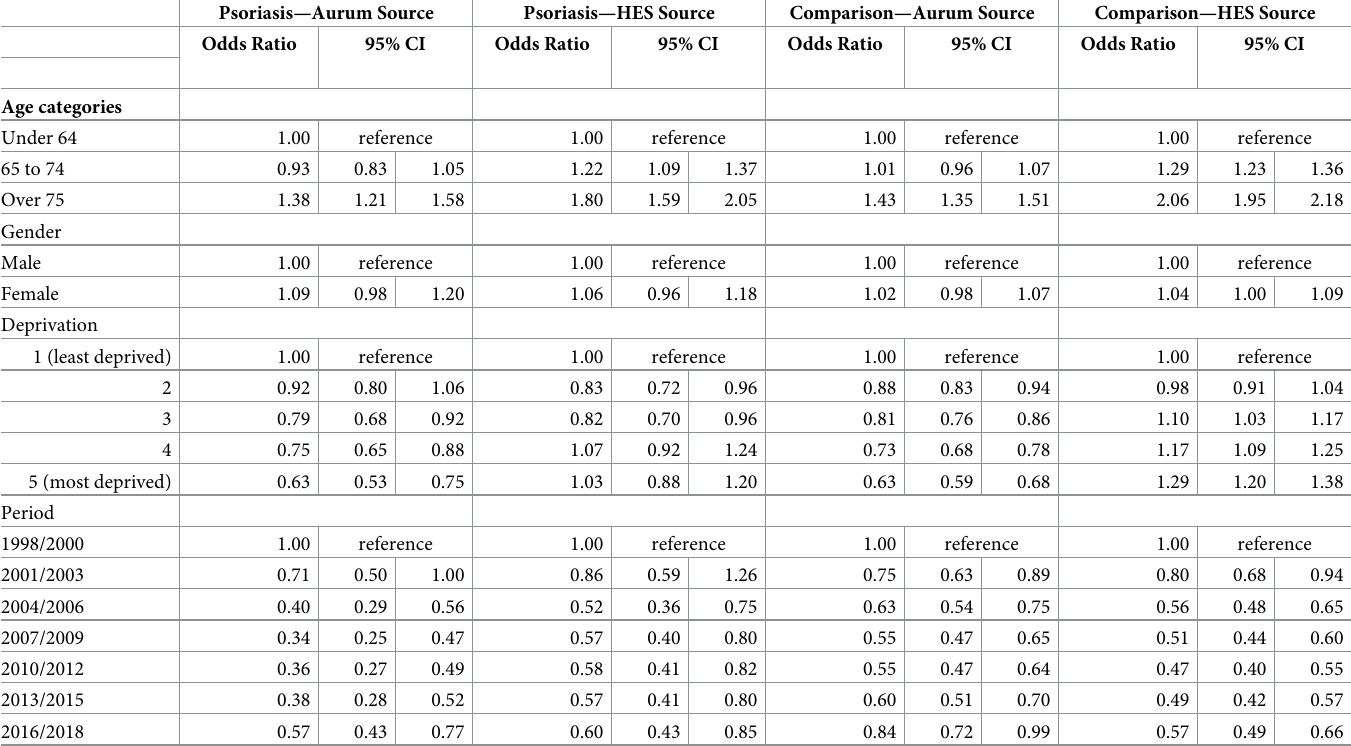
Table 3. Multivariable-adjusted odds of non-concordance according to covariates in CPRD-Aurum and linked HES data. Psoriasis—Aurum